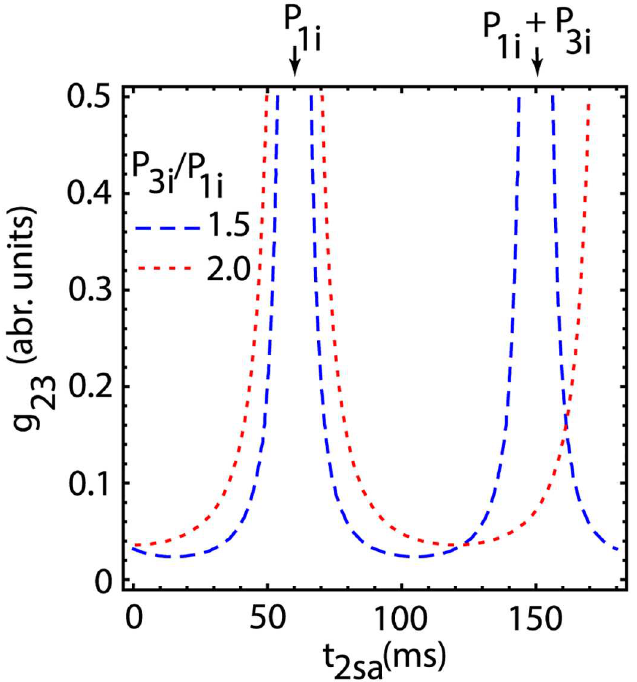
Fig 4. Minimum coupling strength g 23 required for a given phase-locked mode time t (cid:3) multiplepossiblesolutionsfor t (cid:3) for the same couplingstrength betweenneurons#2 and #3 due to the PRC 2 sa periodicity. In the limit case of a very strong coupling( g 23 1 ) the phase-locked stimulus time becomes t (cid:3) þ kP P (see the vertically 1 i 3 i